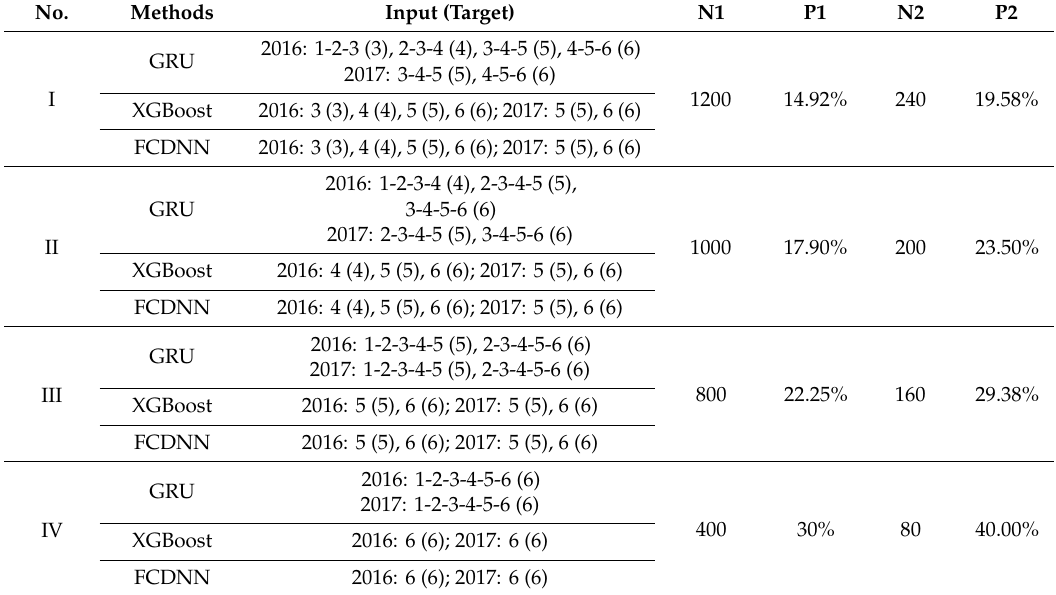
Table 2. Settings of di ff erent calculations (N1: Number of training samples; P1: Percentage of diseased samples in the train set; N2: Number of testing samples P2: Percentage of diseased samples in the test